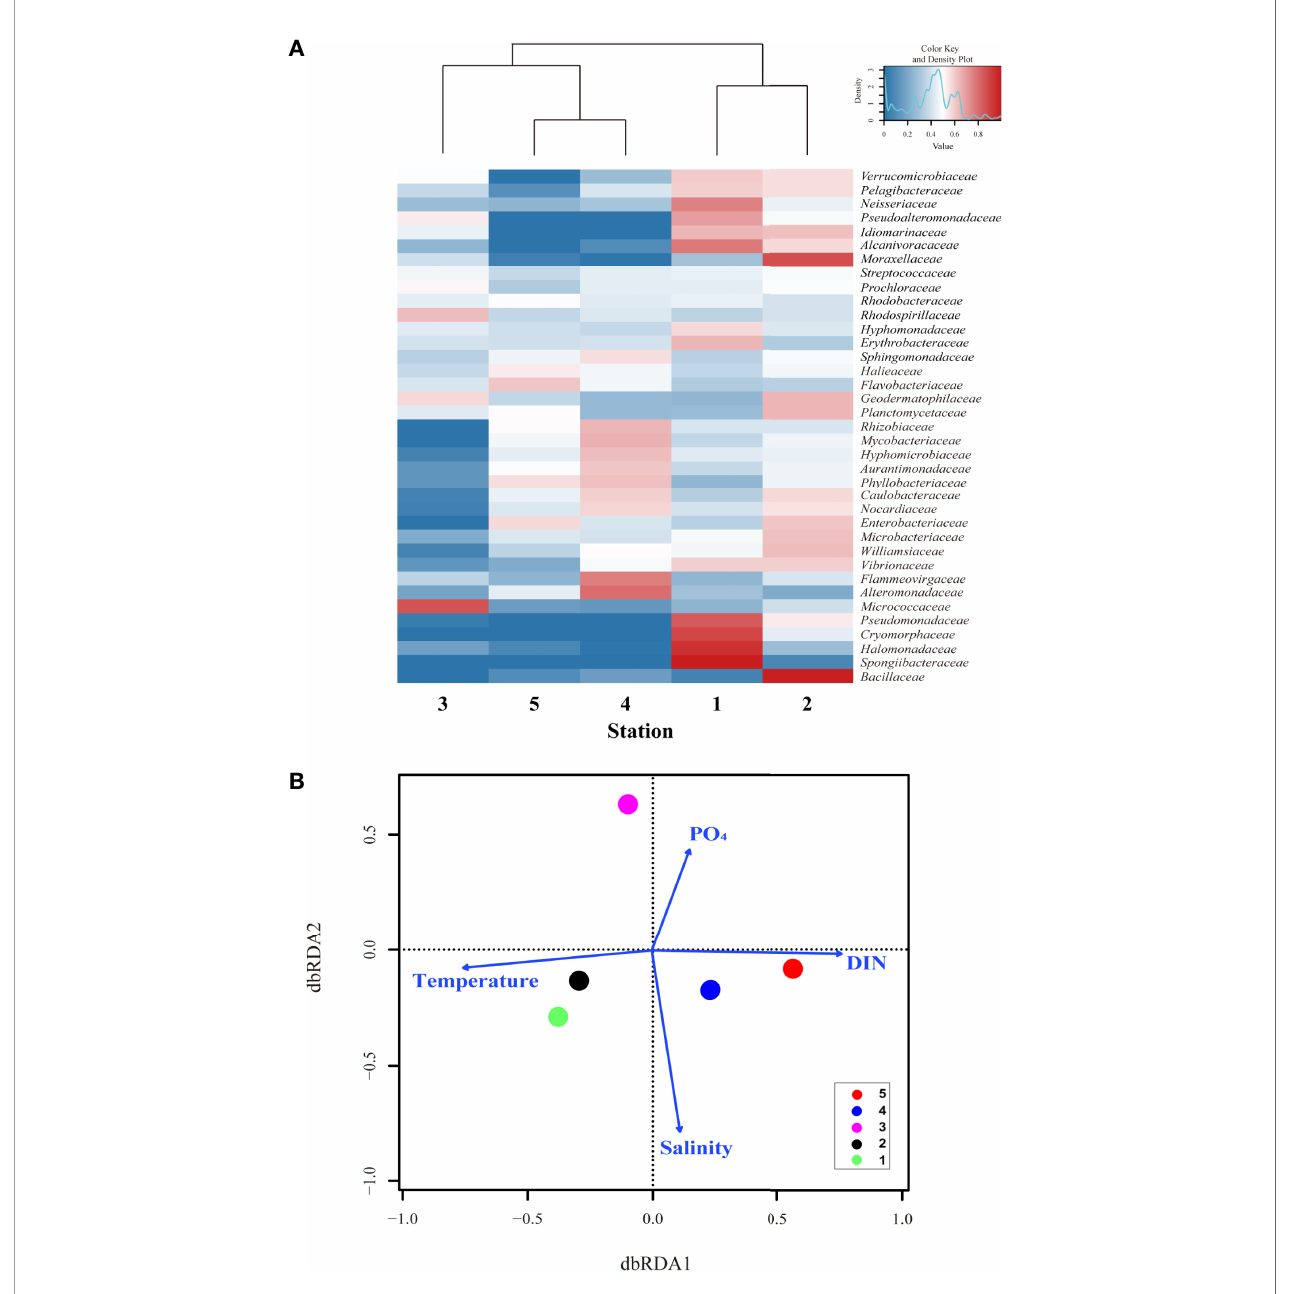
FIGURE 3 | The distance-based redundancy analysis (dbrda) ordination plot and heatmap revealed that environmental conditions controlled the surface bacterial community composition in summertime of UB. (A) hierarchical heatmap showing the relative abundance 37 genera at family level. Color code indicates the relative abundance, ranging from blue (low relative abundance) to red (high relative abundance); and (B) the dbrda ordination diagram of bacterial communities based on OTU at family level and related physical and biogeochemical factors, including temperature, salinity, dissolved inorganic nitrogen (DIN), and phosphate (PO 4 )